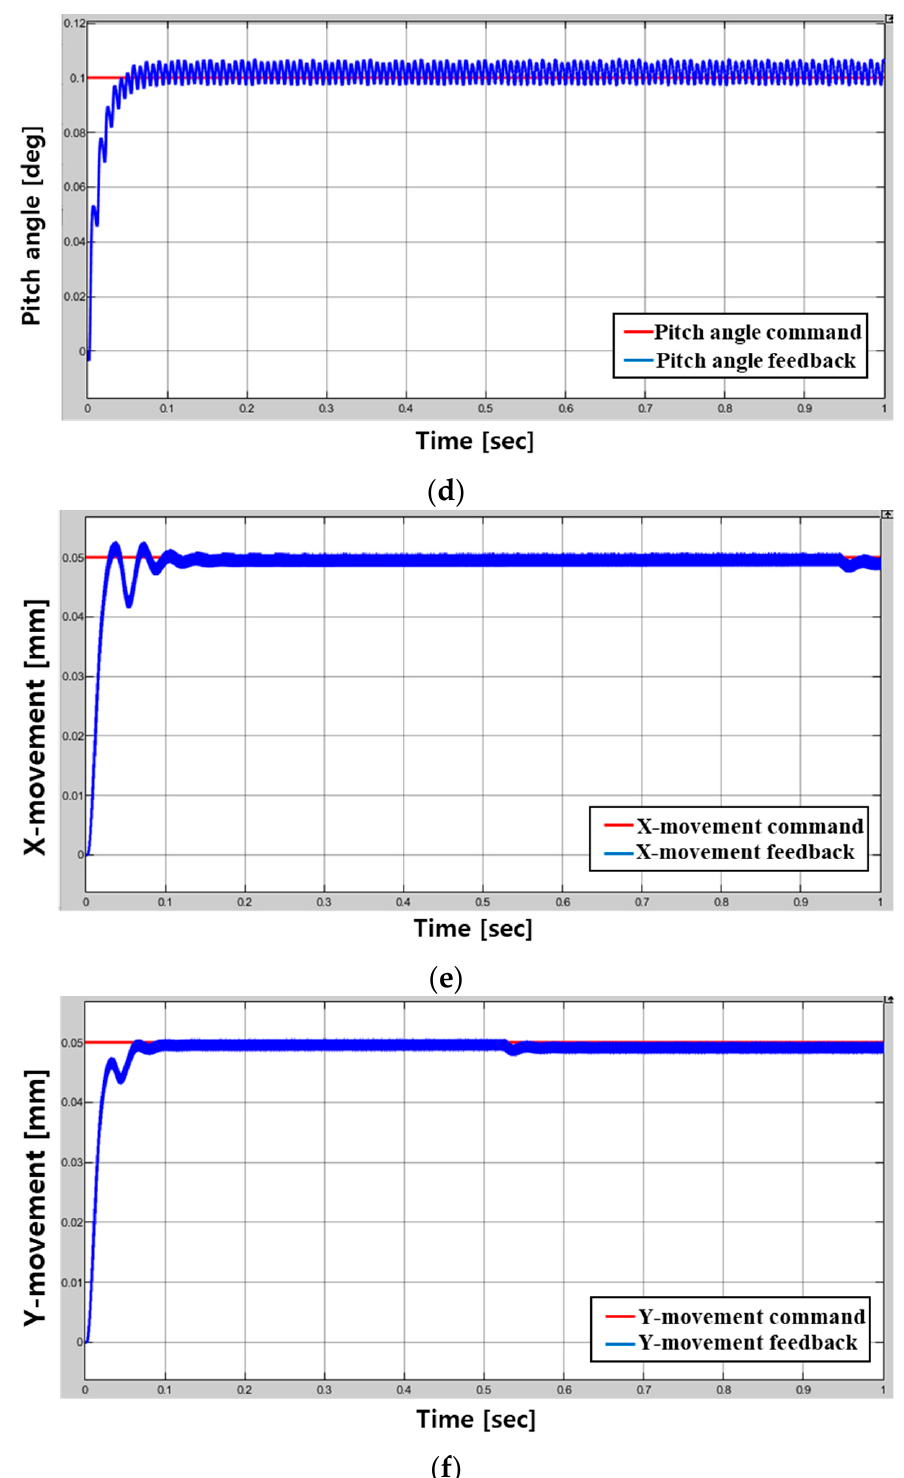
Figure 16. Results of the control simulation: ( a ) Rotation, ( b ) Levitation, ( c ) Roll, ( d ) pitch, ( e ) X-axis movement, ( f ) Y-axis movement.